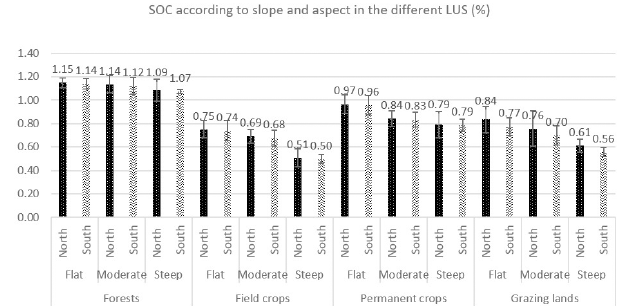
Figure 6. SOC contents according to slope and aspect for the dif- ferent land use